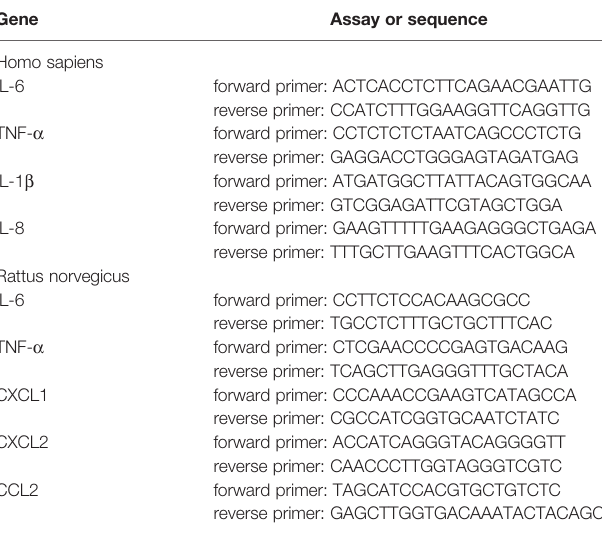
TABLE 1 | Real-time PCR assays/sequences. Gene Assay or sequence Homo sapiens